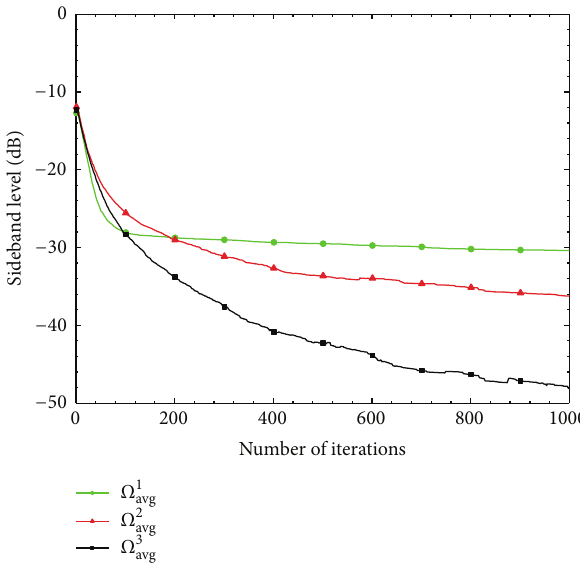
Figure 16:Sideband level variation ofthethreemethodsforSC— Ω 𝑘 representsthemaximumsidebandleveland 𝑘 representsthemethod used, where 𝑘 = 1 : SBL, 𝑘 = 2 : SR, and 𝑘 = 3 :